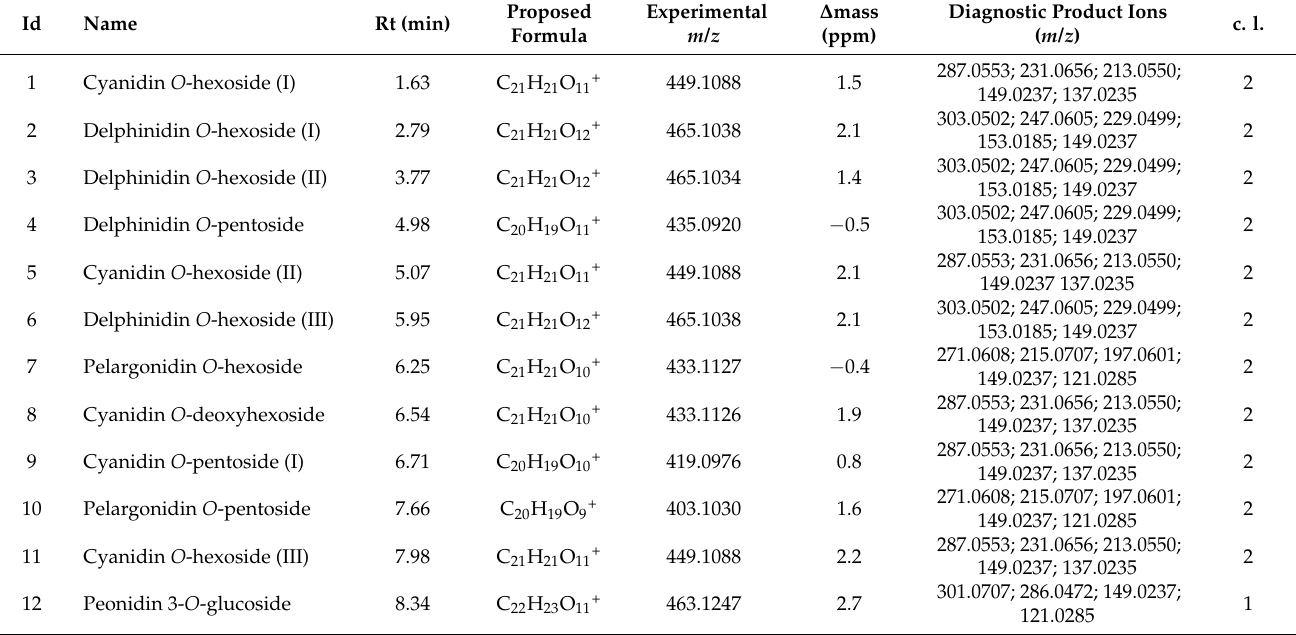
Table 1. Retention times (Rt, min), proposed formulas, experimental m/z , accuracy ( ∆ , ppm), main diagnostic experimental product ions, and confidence level of the identification (c. l.) of the 18 tentatively identified anthocyanins in Disterigma alaternoides extract in